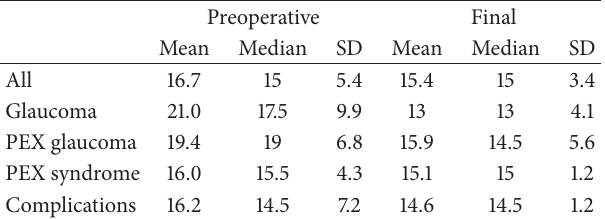
Table 4: Changes in intraocular pressure before and after operation.